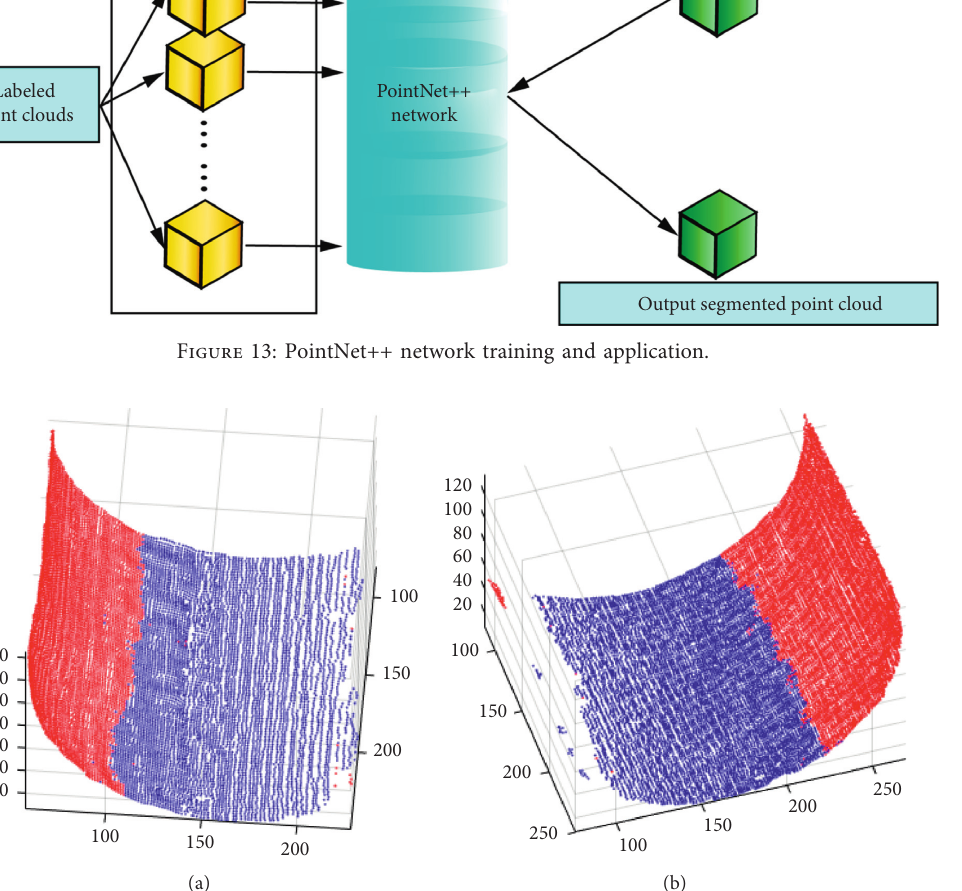
Labeled point clouds